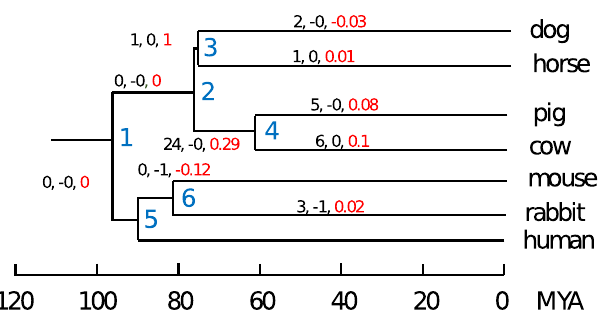
Figure 3. Gain and loss of repeat-derived miRNA clusters across the phylogenetic tree, as inferred by Dollo parsimony. The tree labelling is equivalent to Fig.